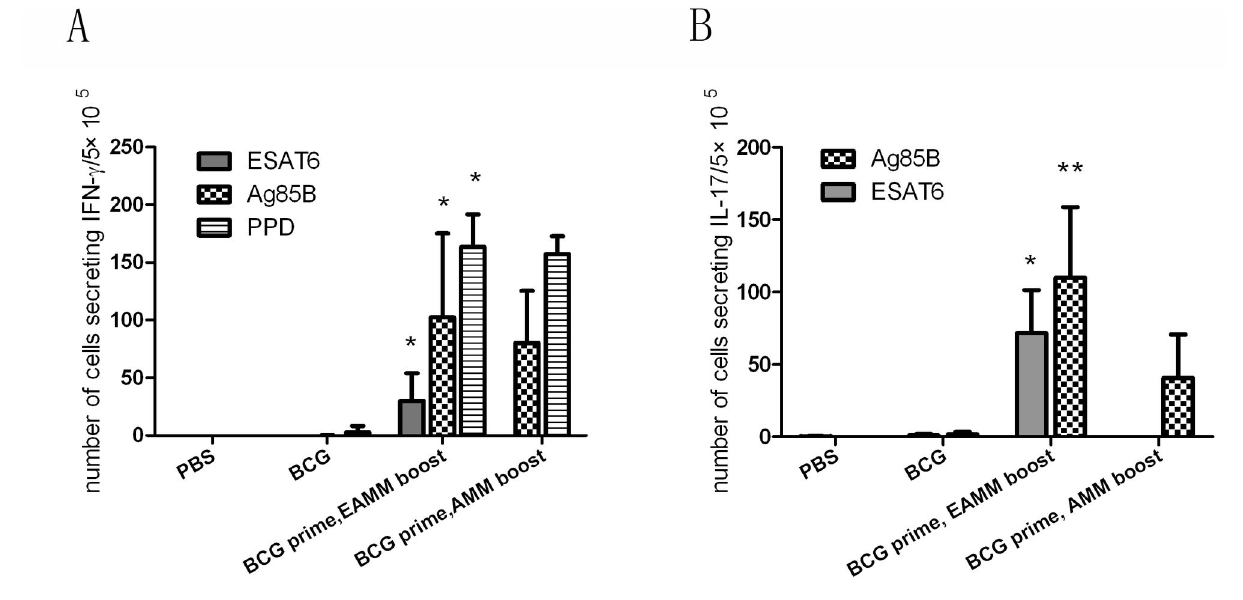
Figure 5. IFN-γ and IL-17 secretion in splenocytes of mice primed with BCG and boosted with subunit vaccine candidates. C57BL/6 mice were primed with BCG, and boosted twice with EAMM or AMM emulsified in the adjuvant of DDA/TDM by s.c. at 12 and 14 week after prime. Six weeks after the last boosting, spleen cells were stimulated with purified protein derivative of tuberculin (PPD), ESAT6 or Ag85B in vitro respectively, and IFN-γ and IL-17 were assayed by ELISPOT. (A) IFN-γ secretion in splenocytes. (B) IL-17 secretion in splenocytes. Results are presented as mean ± SD, n = 4. * p < 0.05 vs. PBS and BCG groups;. ** p < 0.05 vs. PBS, BCG and BCG/AMM groups. doi: